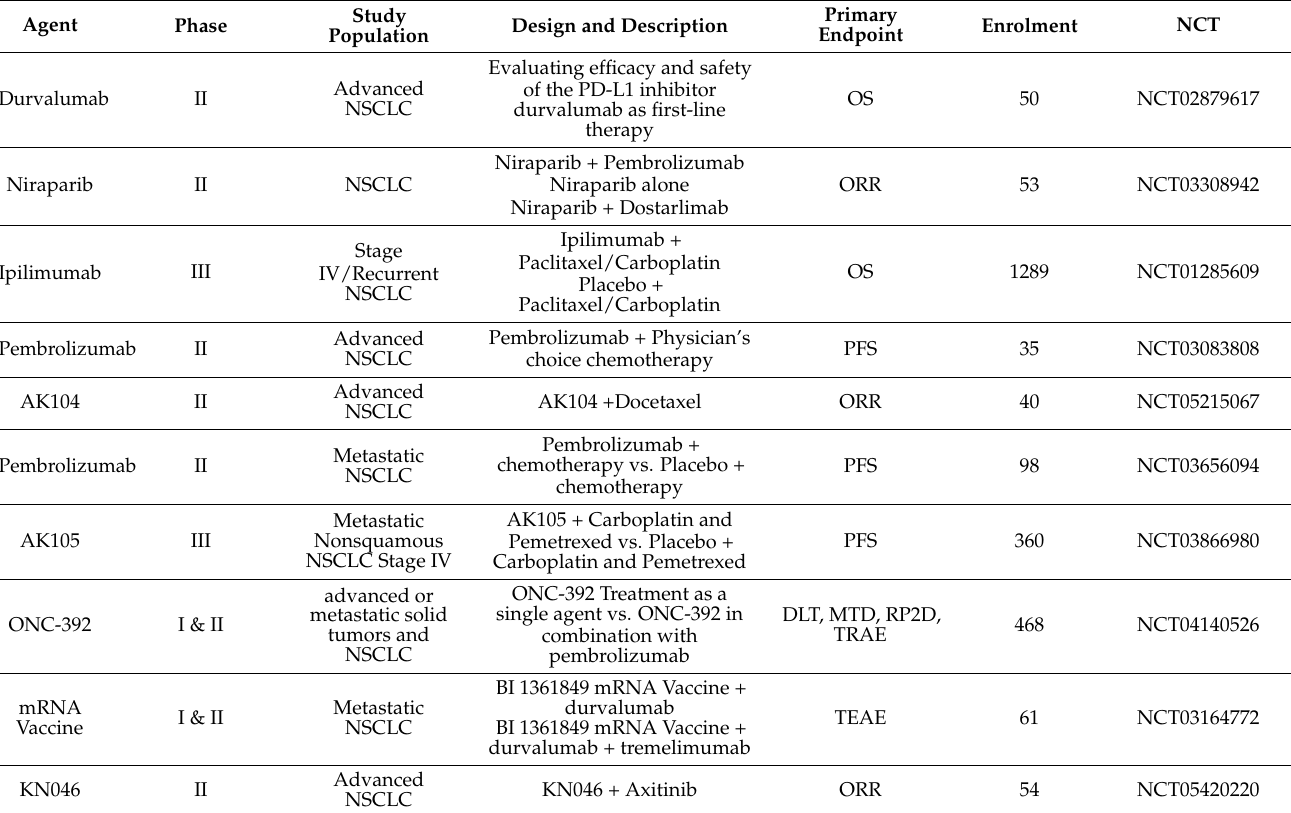
Table 3. Current and completed clinical studies of PD-1 and CTLA-4 ICIs (Data source: https: //clinicaltrials.gov/ (accessed on 1 July 2022))